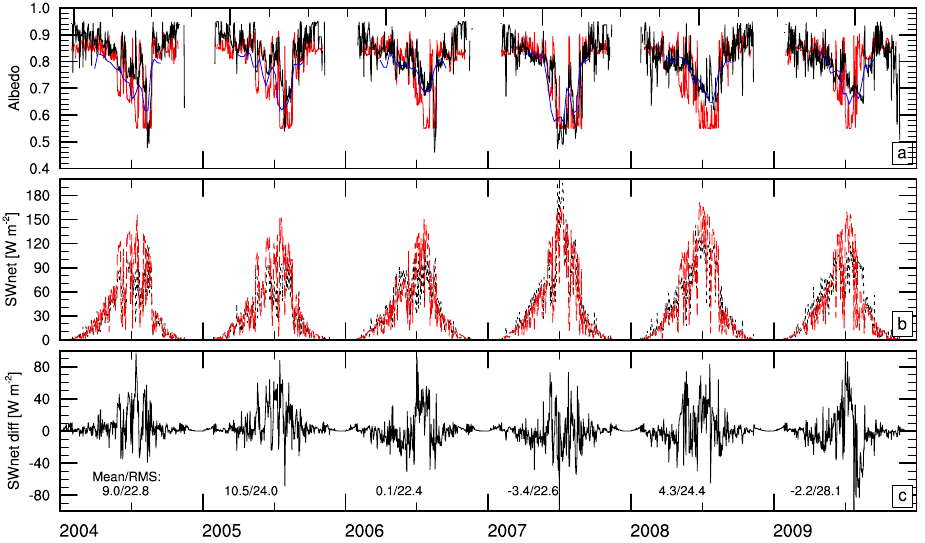
Fig. 6. (a) Albedo at location S9 for AWS data (black), MODIS observations (blue) and final (CONTROL) RACMO2 simulation (red). (b) Net shortwave radiation at location S9 for AWS data (black) and RACMO2 (red). (c) Difference in net short wave radiation between RACMO2 and AWS. The numbers represent mean and root mean square difference (on a daily basis) for the individual years.